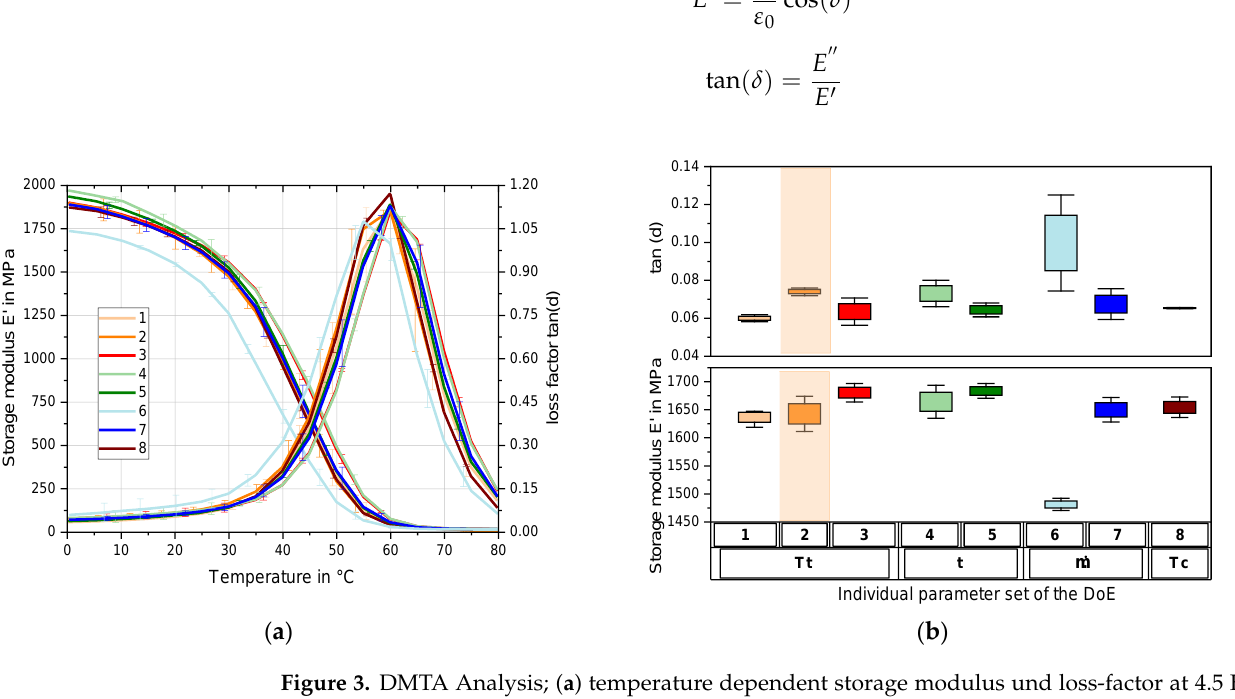
Figure 3. DMTA Analysis; ( a ) temperature dependent storage modulus und loss-factor at 4.5 Hz; ( b ) process dependent values at 23 °C for the Storage Modulus and the Loss Factor (reference in orange).